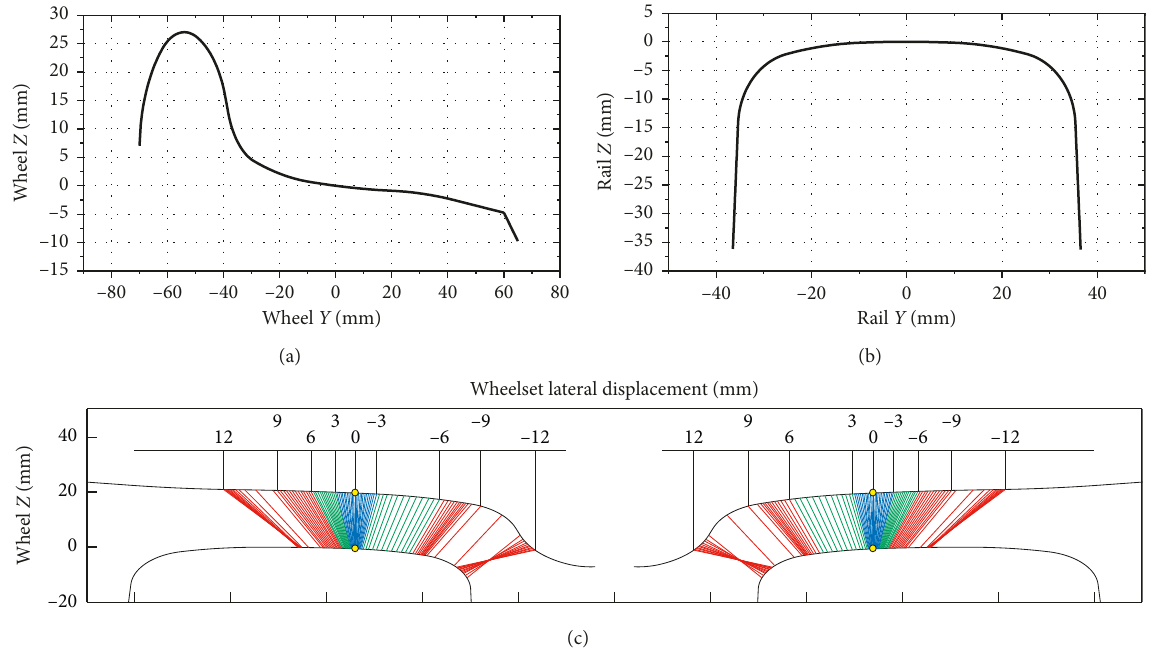
Figure 12: Wheel-rail contact geometry: (a) LM wheel tread profile; (b) CHN60 rail profile; (c) wheel/rail contact points